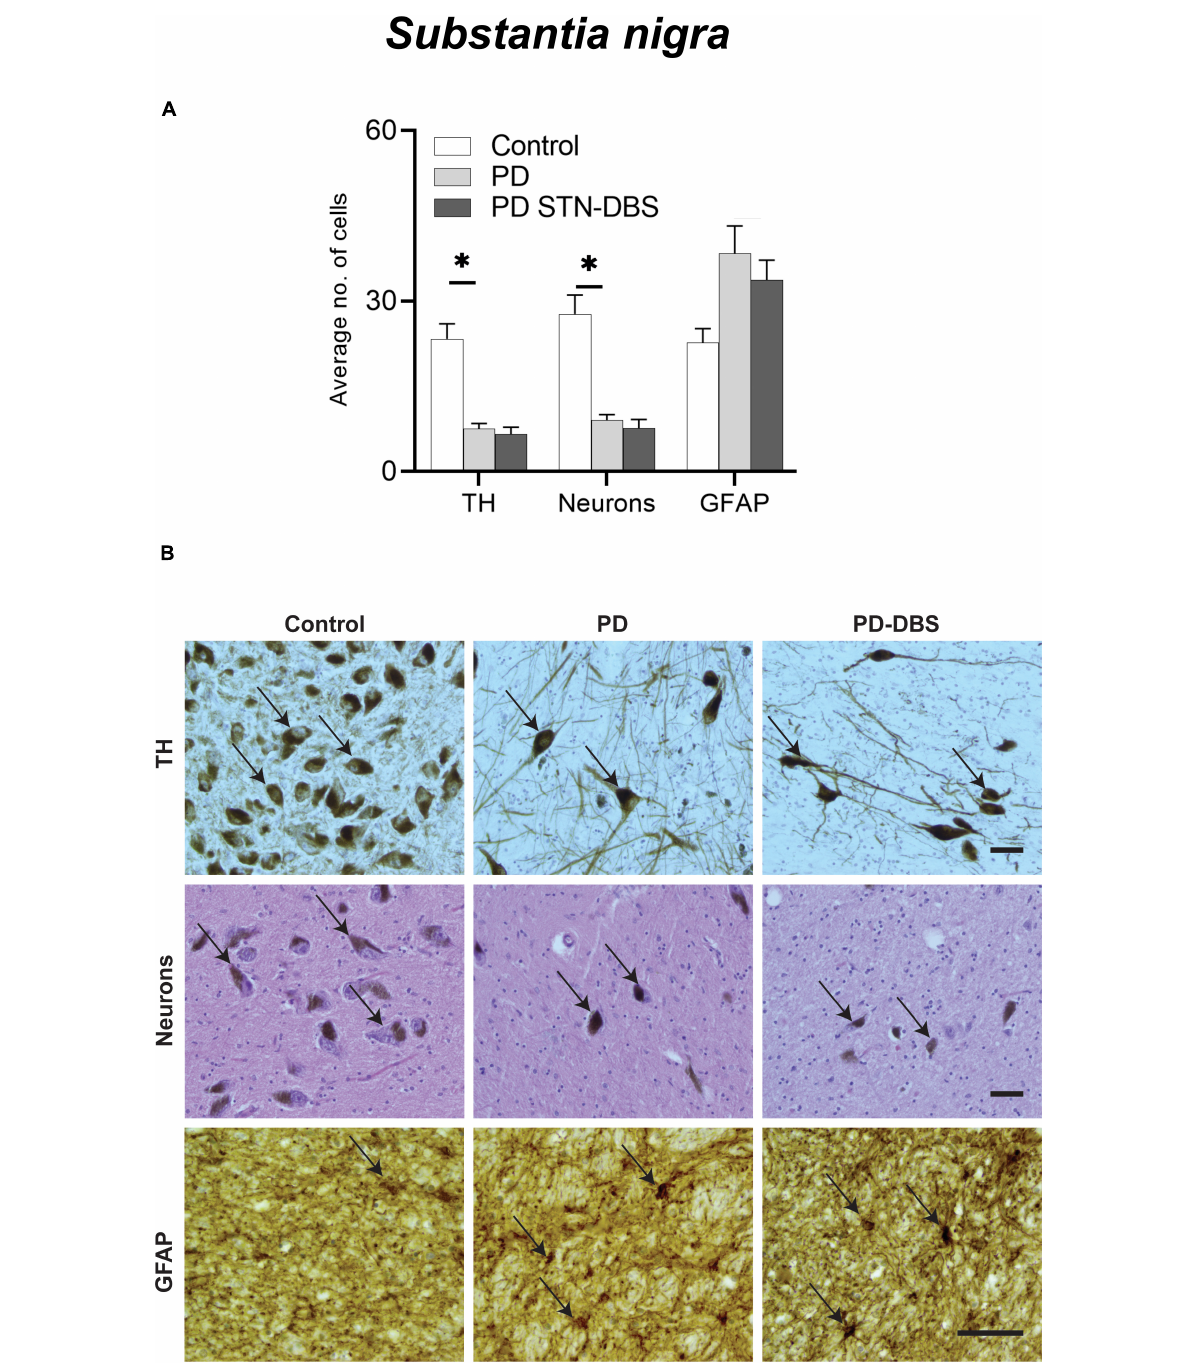
FIGURE1 Quantitation of neuronal loss and astrogliosis in the substantia nigra (SN) of control, Parkinson’s disease (PD) and PD STN-DBS cases. (A) Significant differences between control and PD cases were observed in neuronal loss ( p < 0.018), TH neurons ( p < 0.015), and astrogliosis (GFAP: p = 0.028). Comparison of PD patients with STN-DBS and PD patients without STN-DBS showed no differences in neuronal loss ( p = 1.000), TH neurons ( p = 1.000), or inflammatory marker (GFAP: p = 1.000). (B) Representative photomicrographs of TH (black arrows showing dopamine neurons), neuronal density identified by hematoxylin and eosin (black arrows showing H&E stained neurons), GFAP (black arrow showing astrocyte) in control, PD, and PD STN-DBS in the SN. All images were taken at 200 × magnification. All values are expressed as mean ± SEM. ∗ Indicates p < 0.050. Scale bar = 50